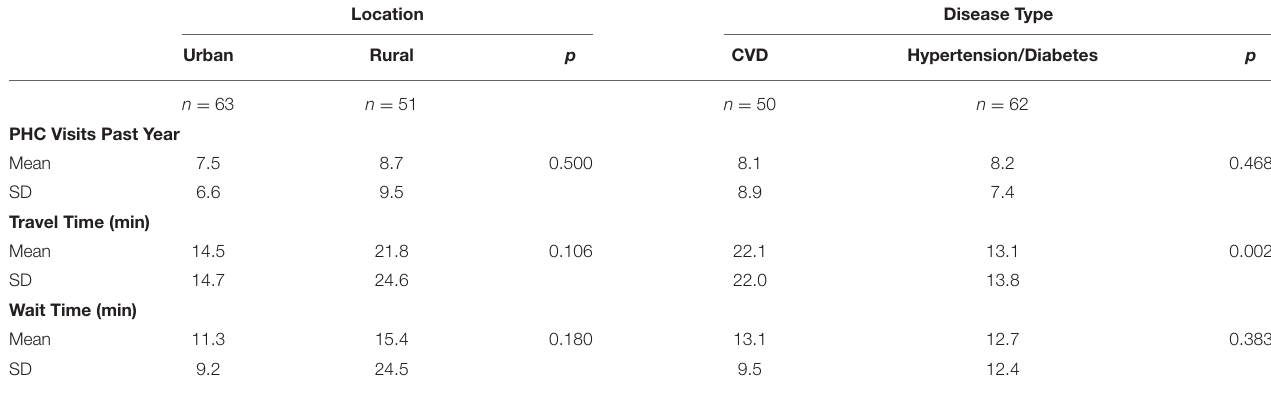
TABLE 2 | PHC Utilization and Time Needed to See a